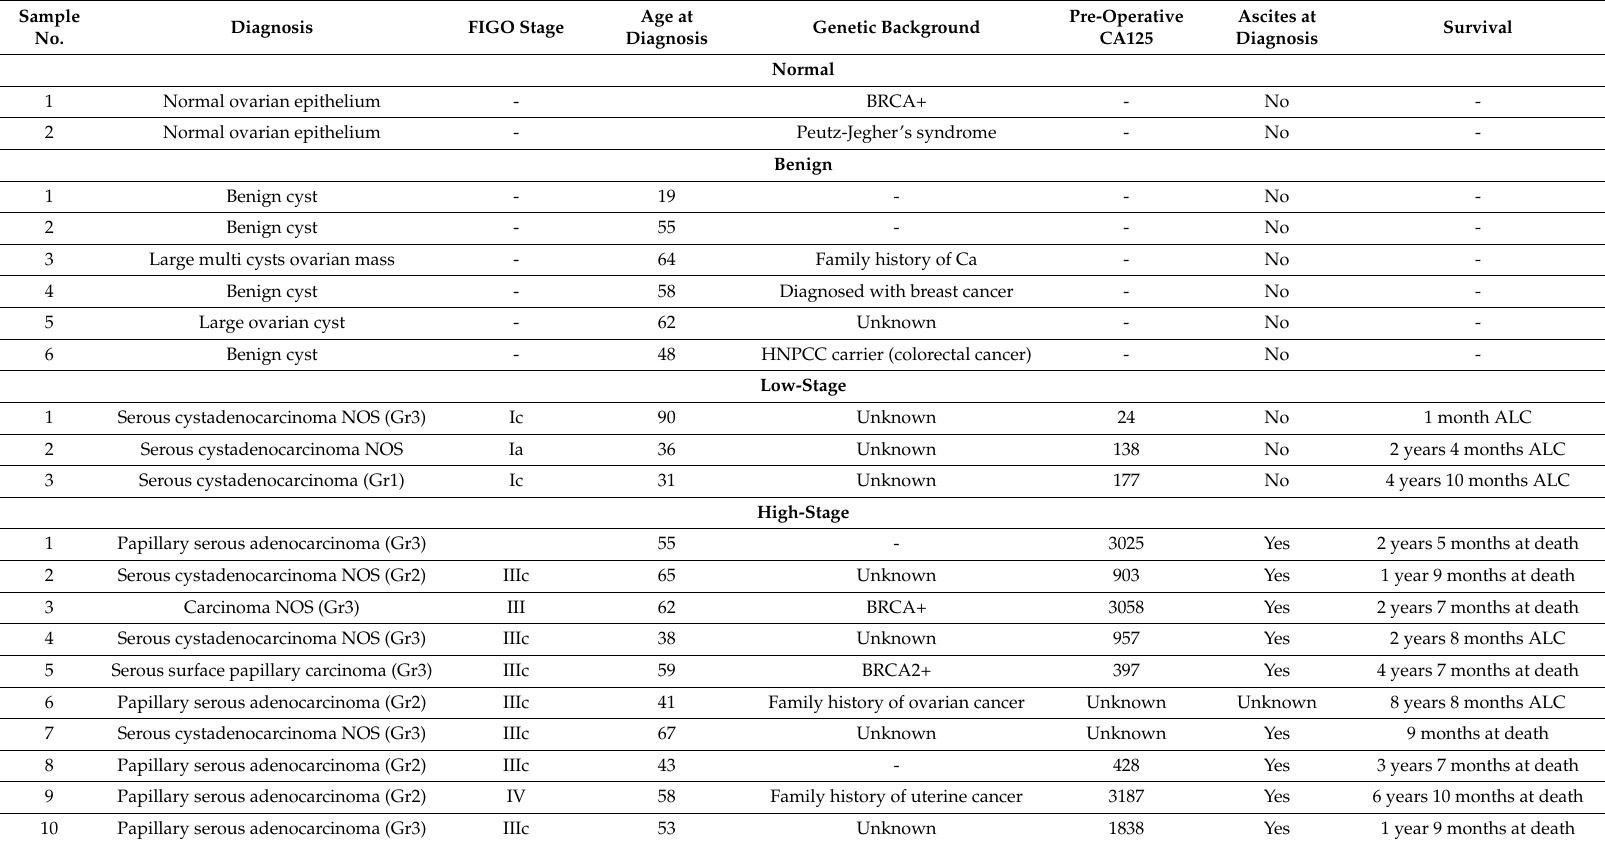
Table 1. Description of patients recruited for immunohistochemistry expression of Src